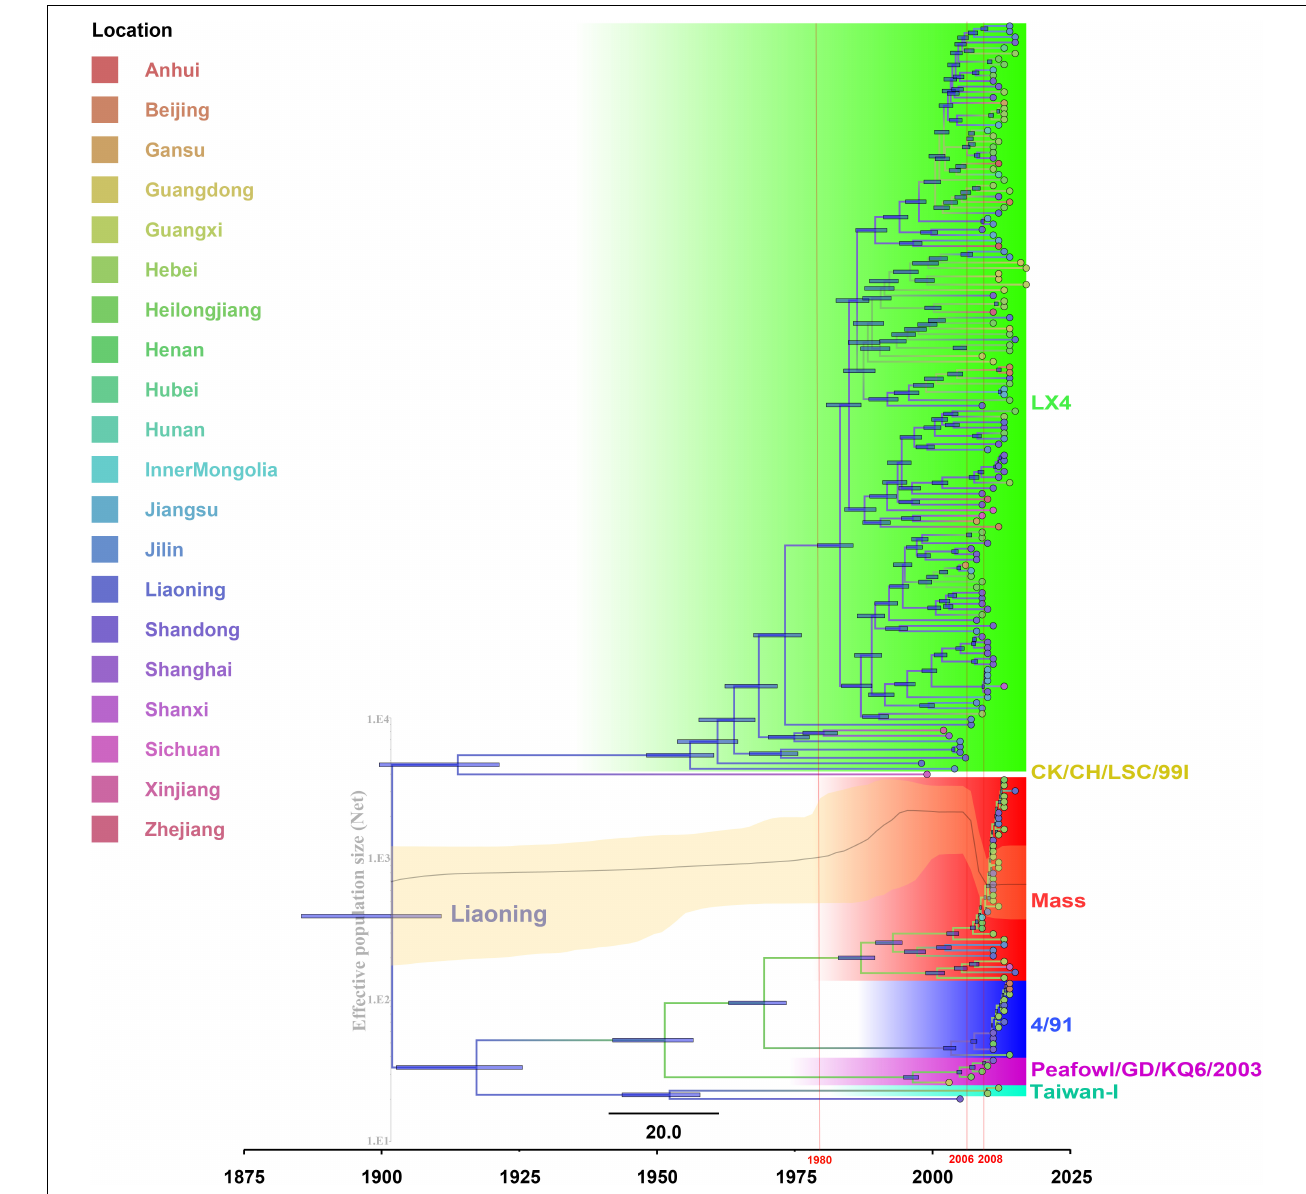
FIGURE 3 | The maximum clade credibility tree and Bayesian skyline plot (BSP) of full-length genome sequences of infectious bronchitis viruses (IBVs) (see section “Materials and Methods” for further details). The maximum clade credibility (MCC) tree was constructed with 10% burn-in by Tree Annotator version 1.10.4 implemented in the BEAST software package. The color of the branches corresponds to geographical areas. A change in branch color indicates a time and geographical area change during the genotype’s evolutionary history. The scale bar represents the unit of time (year). Bayesian skyline plot (BSP) is superimposed to the tree in the same time-scale ( x -axis). The y -axis represents the effective population size (log10 scale). The black line represents the effective population size through time, and the orange area around the line represents the 95% highest posterior density (HPD) of the estimates.